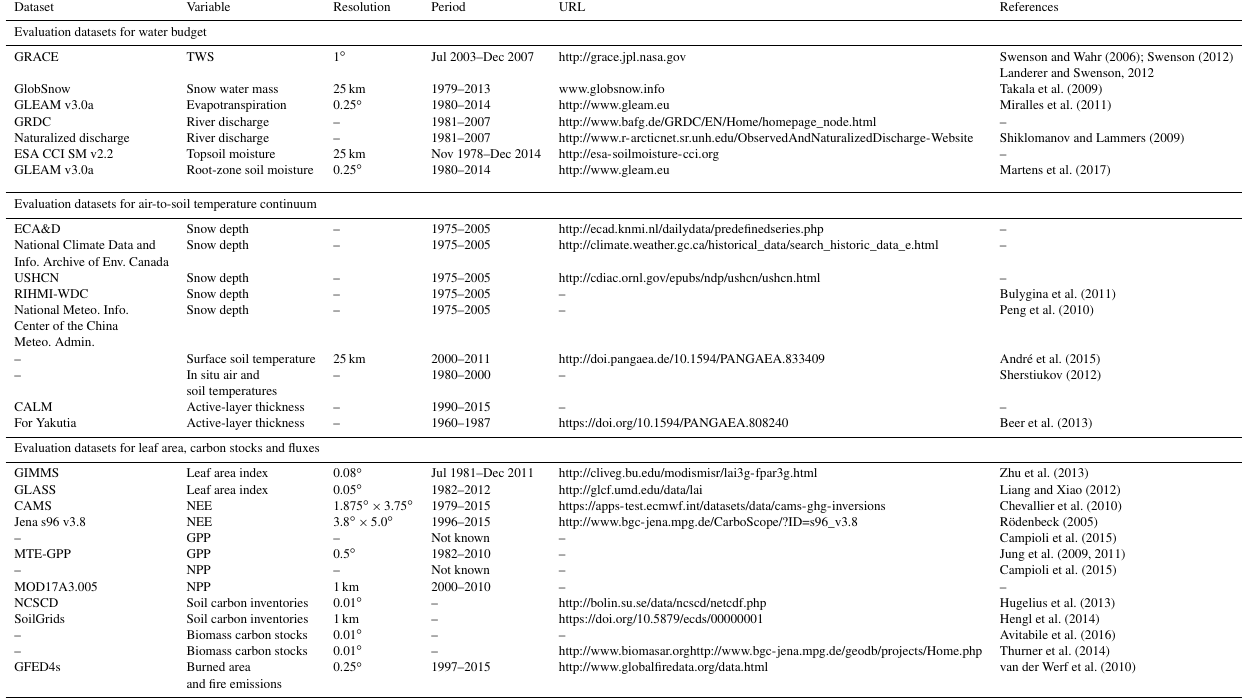
Table 1. List of the datasets used for the ORCHIDEE-MICT evaluation, with their references, the original spatial resolution, and period of